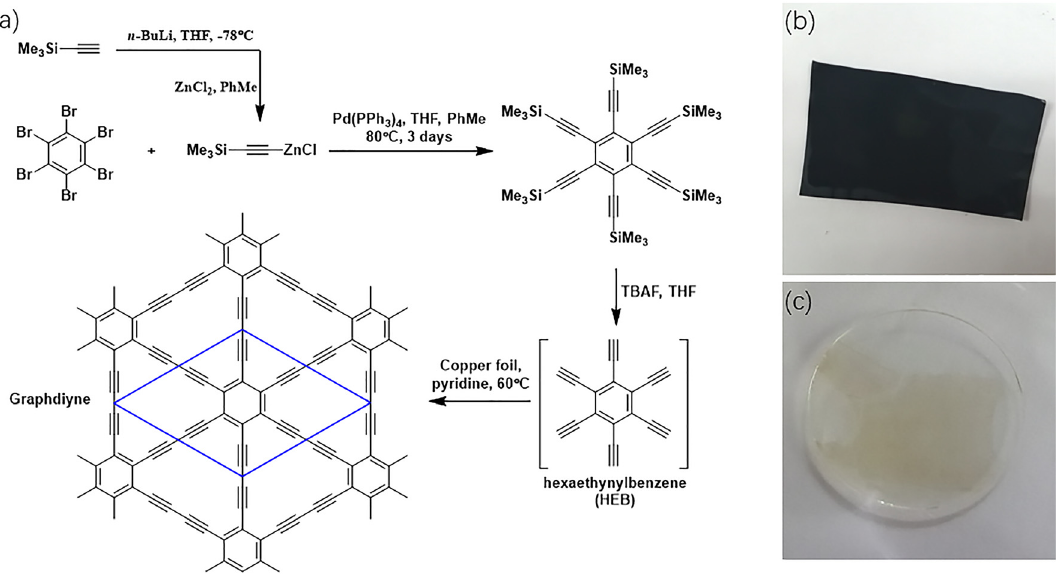
Figure 7: (a) The synthetic route for graphdiyne. (b) The graphdiyne film on copper foil. (c) The graphdiyne film after the liquid-phase